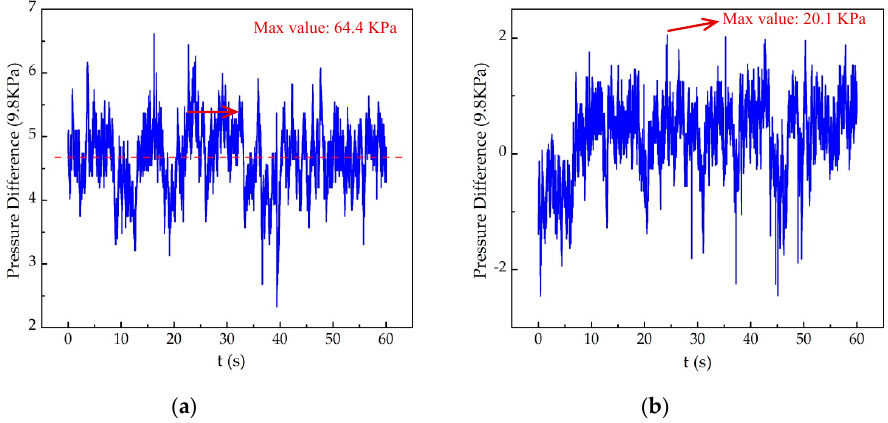
Figure 17. Time histories for the difference between the hydraulic pressures measured at test points e and f under working Condition 1. ( a ) drainage failure plate; and ( b ) self-drainage plate.